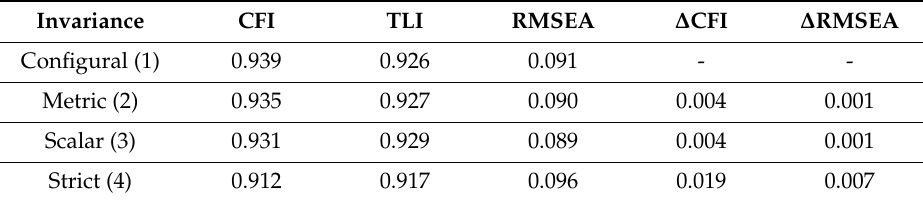
Table 2. Invariance measurement across gender for the POSQ questionnaire.